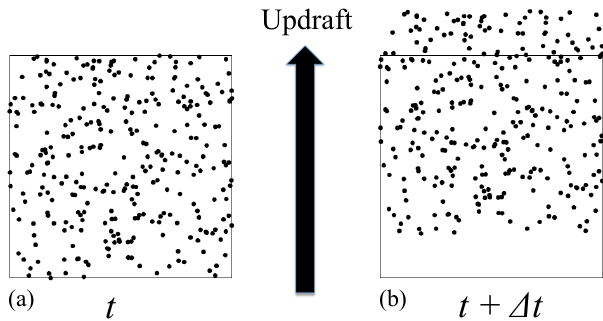
Figure 2. Illustration of the activation as represented on the fluid flow grid. Panel (a) shows locations of CCN activated at a given model time step. Panel (b) shows the situation at the next time step when activated CCN are advected away from the grid cell and acti- vation of new CCN is